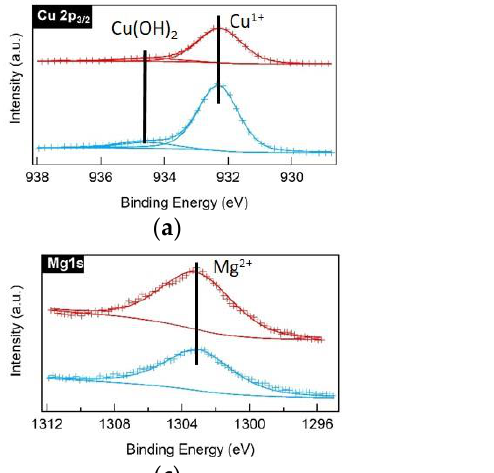
( a ) ( b ) Figure 8. ( a ) Ultraviolet – visible (UV-vis) absorbance and transmission (inset) spectra and ( b ) Tauc plots and linear fits of the band edge (straight lines) for CCO (black curve), 5% Mg:CCO (red curve), and 10% Mg:CCO (blue curve) films. Table 3. Thickness and direct E g of CCO, 5% Mg:CCO, and 10% Mg:CCO films with ~0.22 absorbance at 300 nm wavelength.